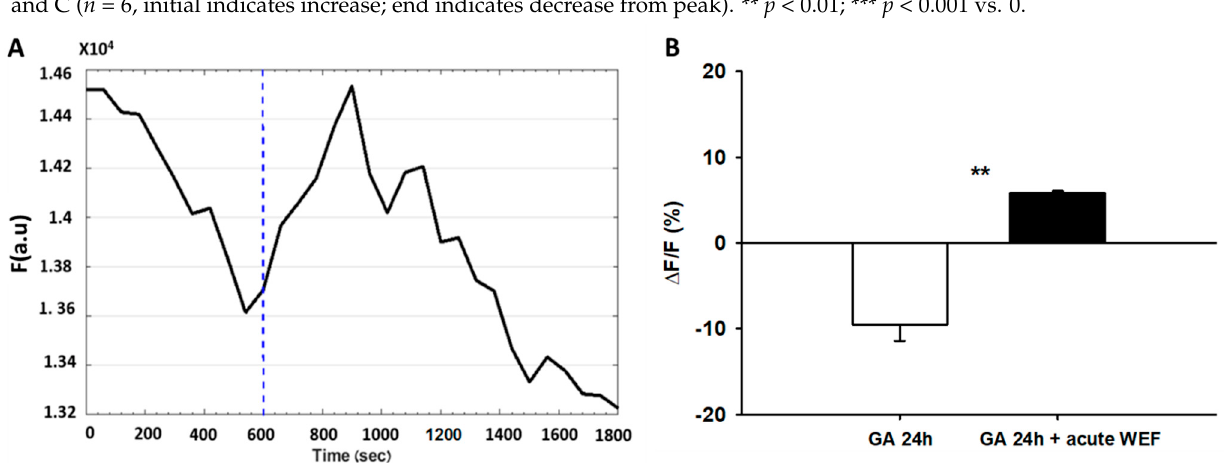
Figure 5. Gambogic acid (GA) does not block WEF-mediated hyperpolarization. ( A ). Representative trace of a cell exposed to GA for 24 h and subsequently exposed to WEF as indicated (dashed line). ( B ). Mean ± SE values for three cells. ** p < 0.01 between groups.